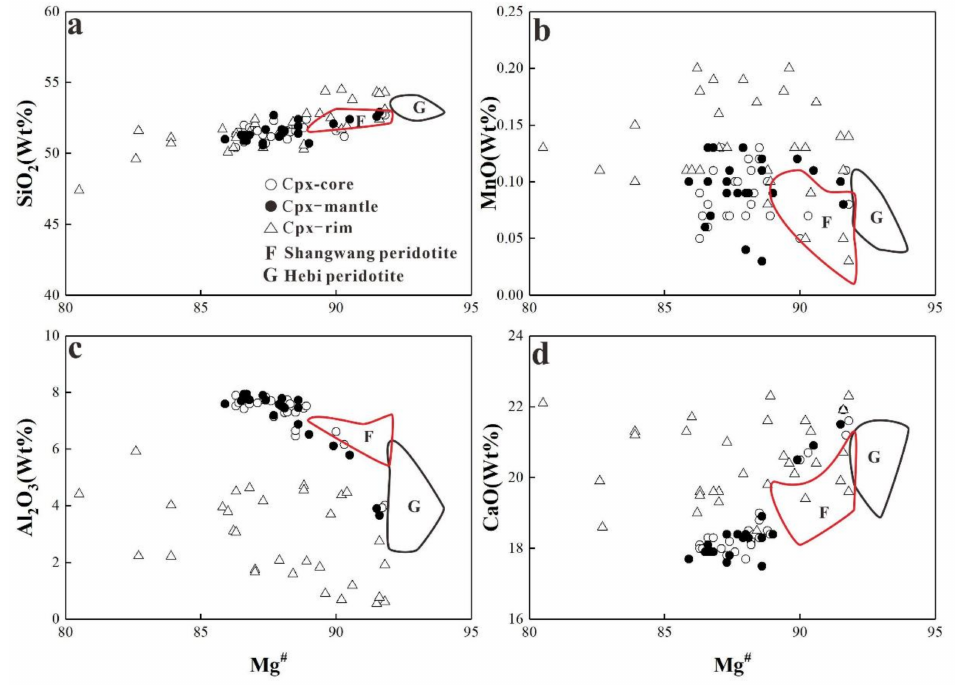
Figure 9. Plots of Mg # vs. SiO 2 ( a ), MnO ( b ), Al 2 O 3 ( c ), and CaO ( d ) for the clinopyroxene (Cpx) in the websterite. Note: The data of Shanwang and Hebi peridotite are the same as Figure 7.